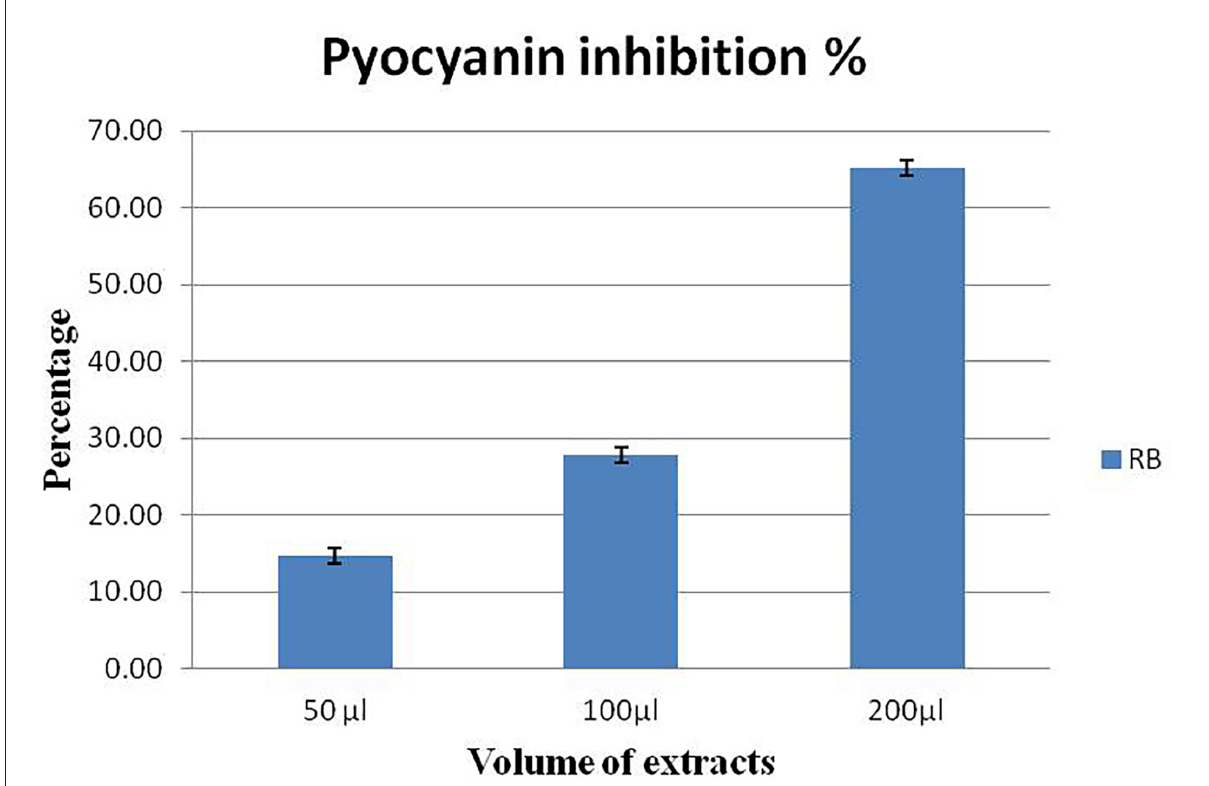
FIGURE4 Concentration-dependent inhibition of pyocyanin pigment in P. aeruginosa MTCC2296. Values represent the mean of three replications. Bars indicate the standard error of the mean.